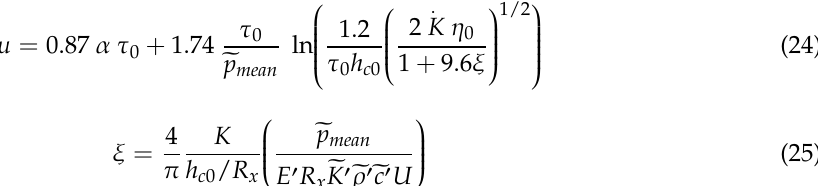
Figure 5. Half width (cid:101) a as a function of a 0 ( δ = γ ) [26].